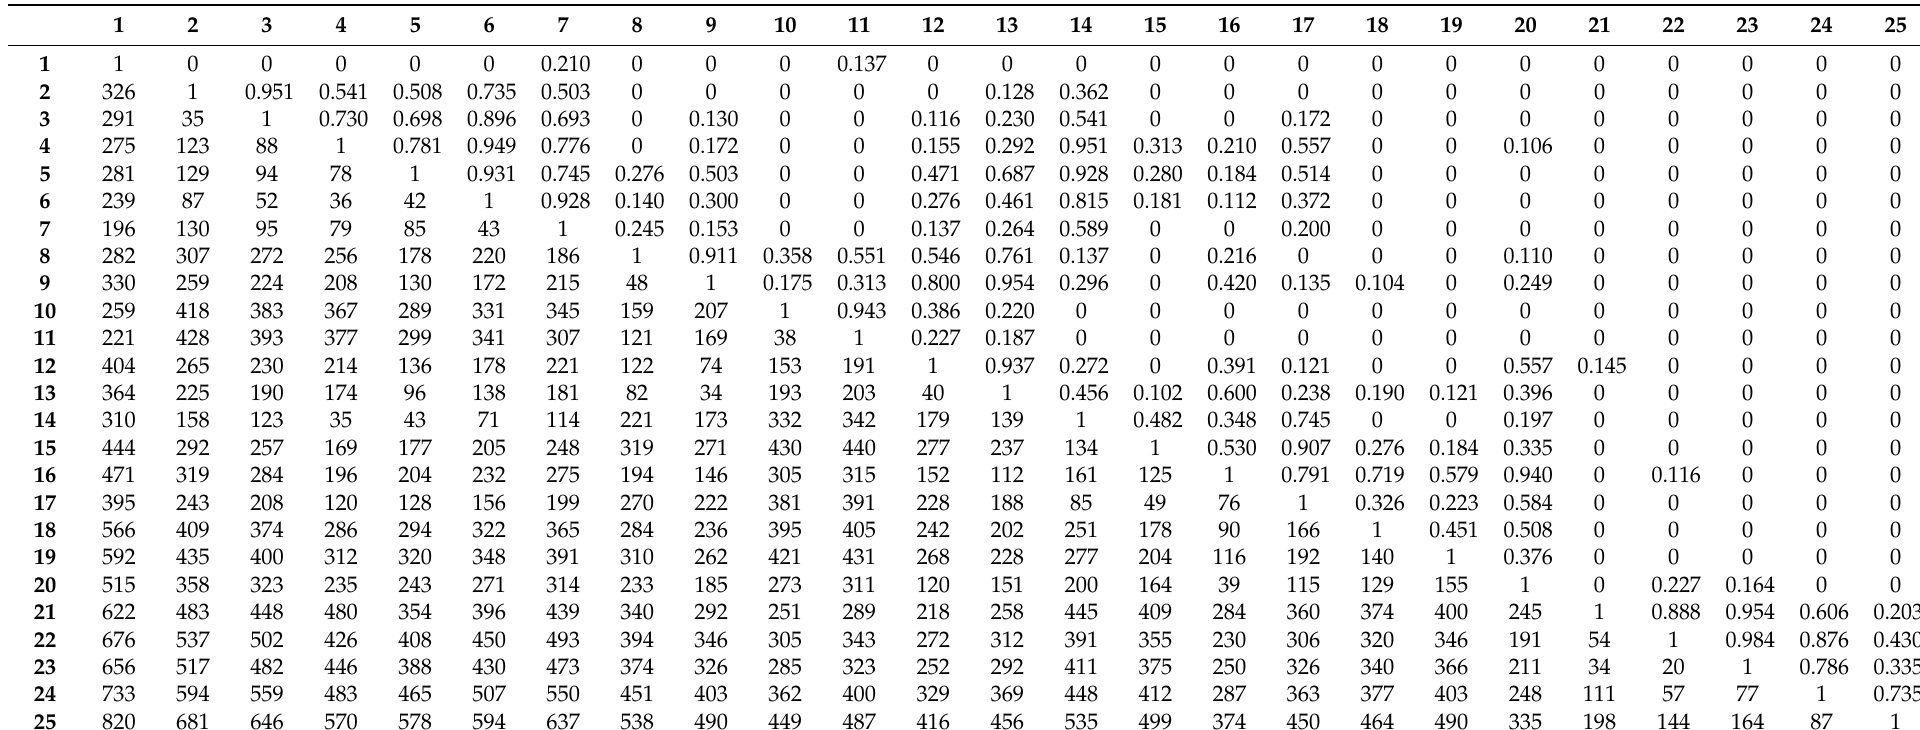
Table 3. The adjacency matrix and the distance of